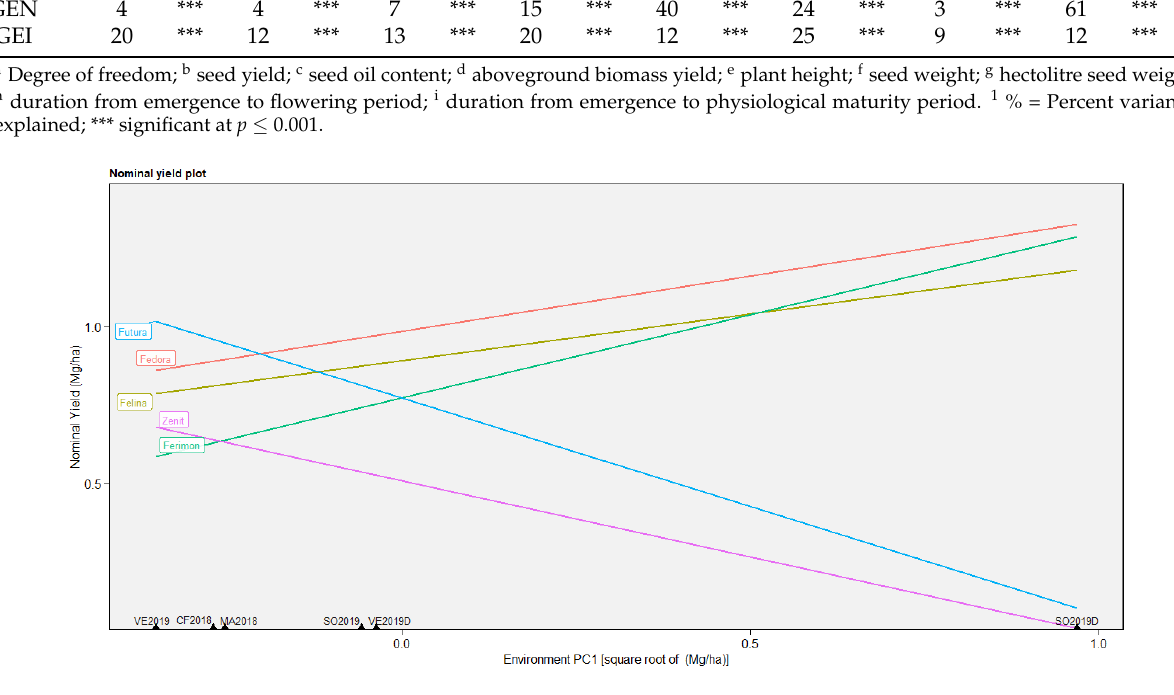
Figure 2. Nominal grain yield for the five hemp cultivars as a function of the environment scores of the first interaction principal component axis (IPCA1).